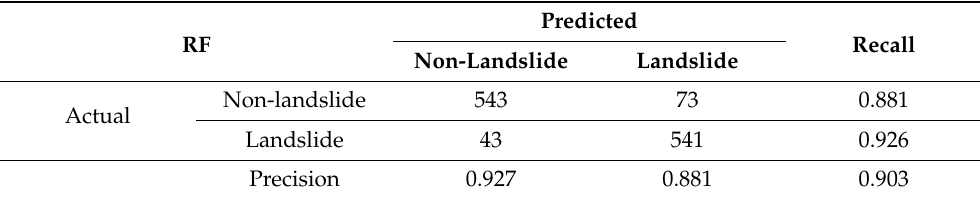
Figure 9. ROC curves and AUC value for evaluating the classification results of landslide susceptibility using the random forest classifier. Table 4. Confusion matrix of the random forest